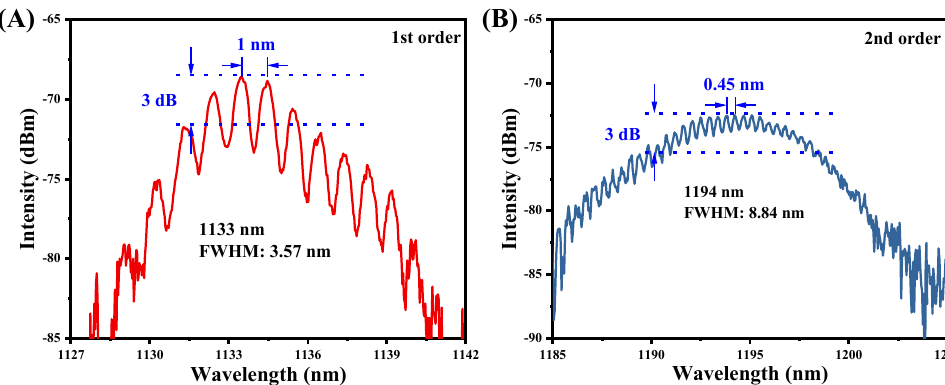
Figure 4. ( A ) Optical spectrum of the 1st-order Stokes wave; ( B ) Optical spectrum of the 2nd-order Stokes wave.